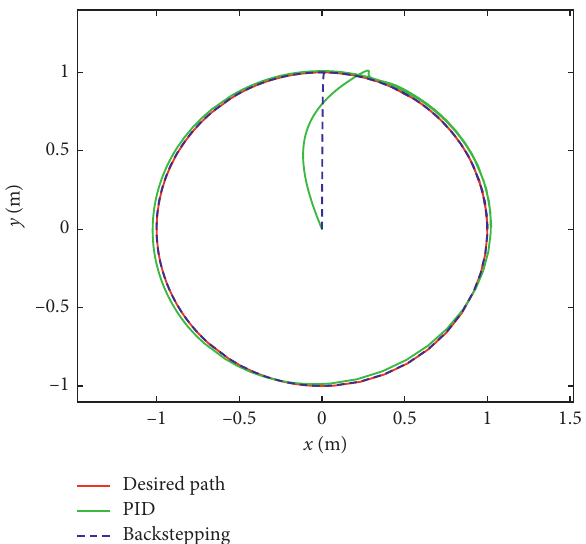
Figure 8: Trajectory tracking performance in the operating space of the